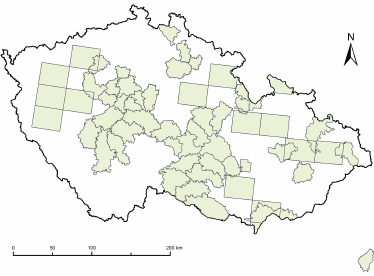
Figure 3. Areal extents of the districts and the map sheets processed in the published Quarry Inventories project